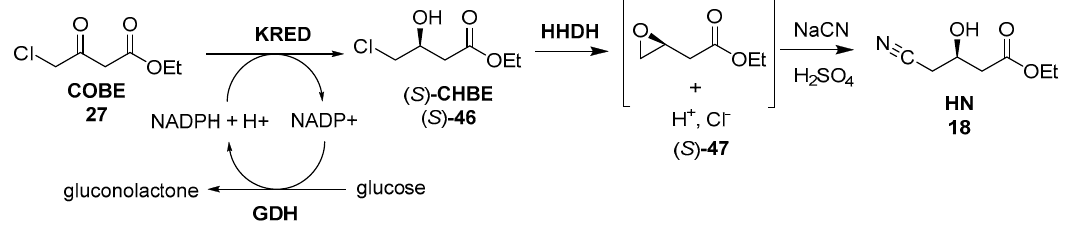
Figure 11. Codexis synthesis of HN .